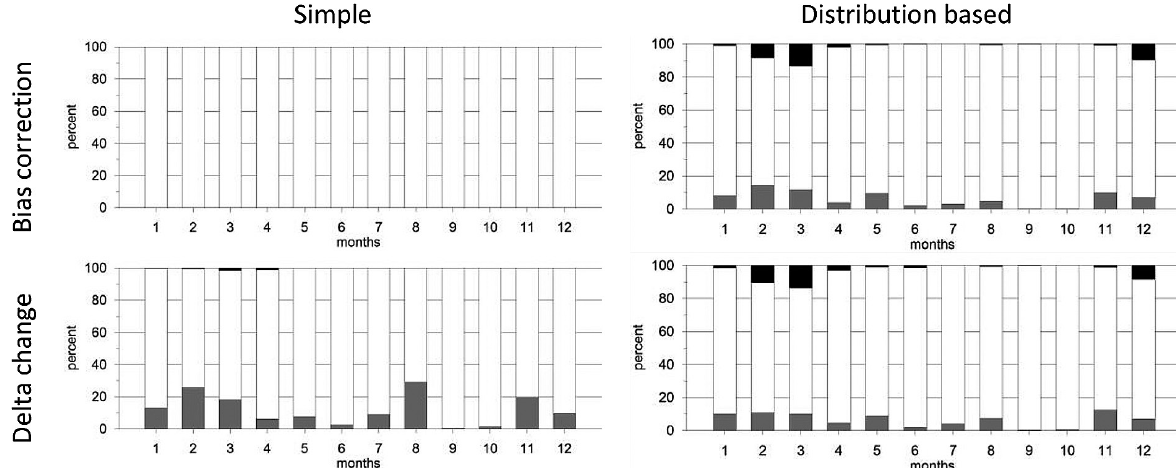
Fig. 4. Frequencies of improvements (grey), no change (white) and worsening (black) after corrections made by different methods for a skewness. Bias correction methods in the upper raw and delta change methods in the lower raw, simple vari- ants in the left column and distribution based variants in the right